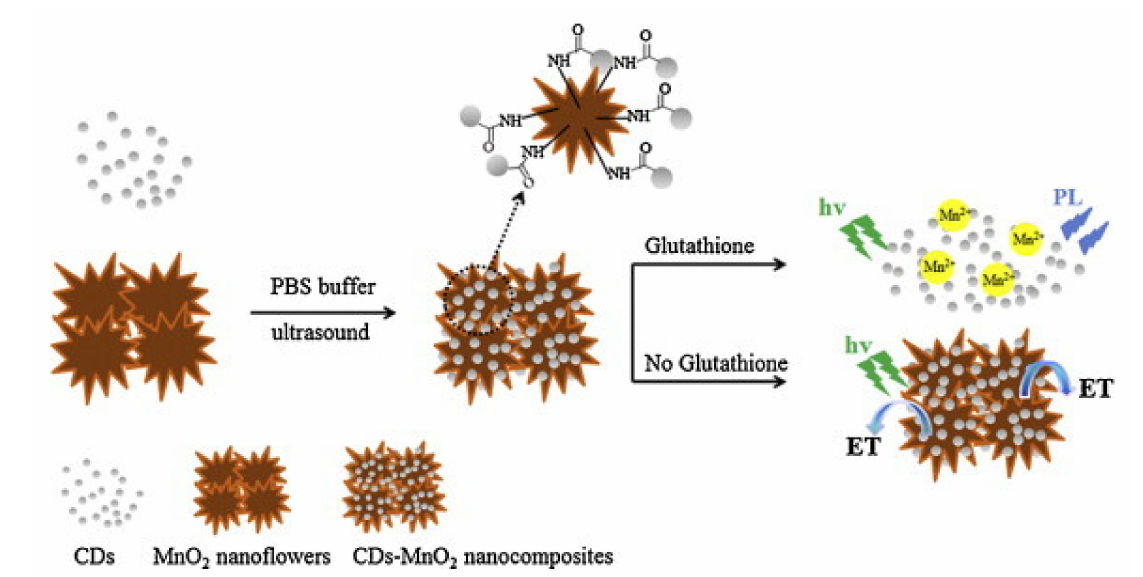
Figure 10. Schematic diagram of GSH detection of CD-MnO 2 nanocomposites